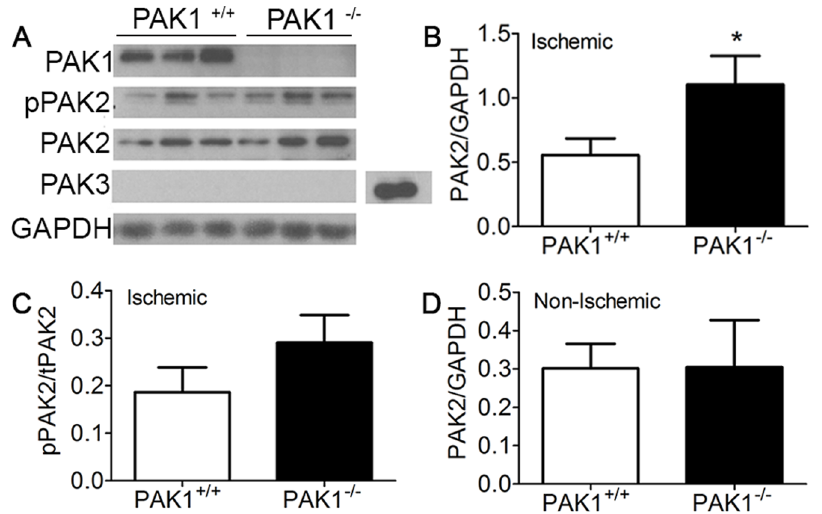
Figure 3. Increased protein expression and phosphorylation of PAK2 in ischemic gastrocnemius muscle in PAK1 2 / 2 compared to PAK1 + / + mice. A) Western blots showing upregulated PAK2 expression and a trend towards increased phospho-PAK2 in PAK1 2 / 2 mice (lanes represent samples from 3 different mice). We did not observe expression of PAK3 in gastrocnemius tissue; however, abundant PAK3 expression is found in mouse brain tissue as can be seen from a positive control sample in lane 7 of the PAK3 blot. B–C) Densitometry analysis reveals a 2-fold increase in PAK2 expression in PAK1 2 / 2 compared to PAK1 + / + mice, normalized to GAPDH as a loading control, and a concomitant increase in phospho-PAK2 relative to total PAK2. *indicates p # 0.05 using Student’s T-test, n=6. D) Densitometric analysis of total PAK2 protein expression in non-ischemic muscle did not reveal a change in PAK1 + / + versus PAK1 2 / 2 mice.